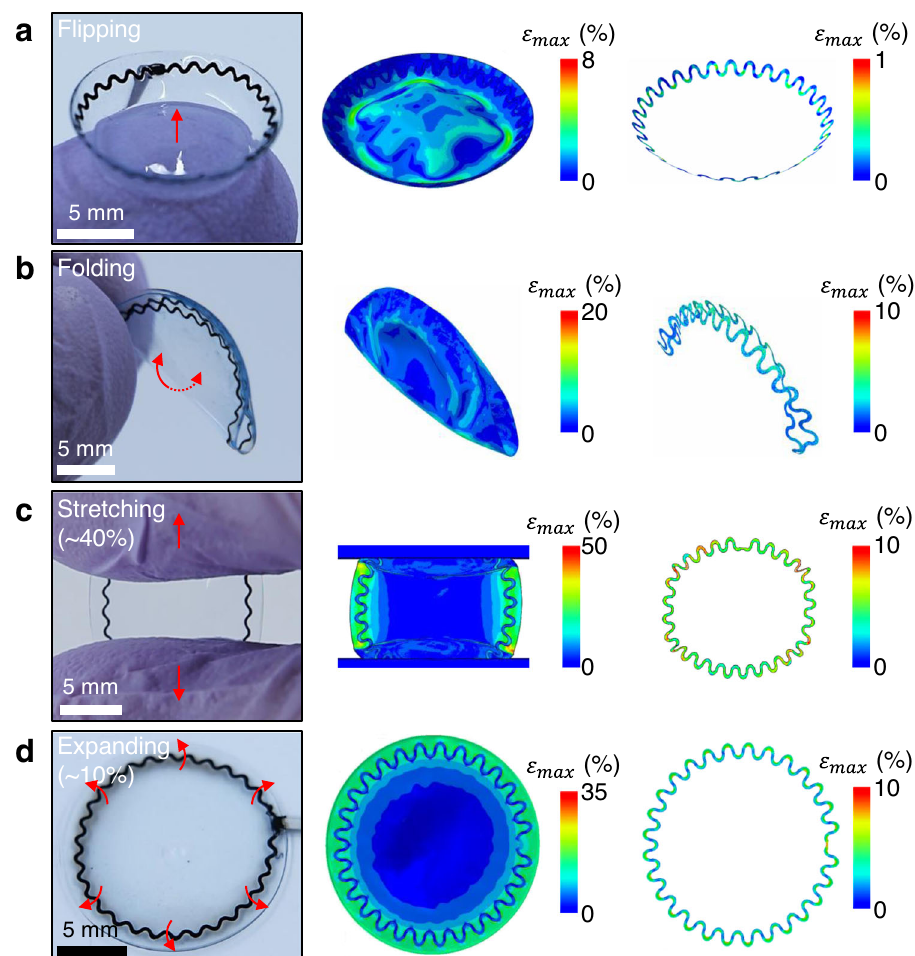
Fig. 3 Mechanics analysis under various loading conditions. Photographs (left column) and fi nite element analysis (FEA) results (middle column) of the corneal sensor under four different loading conditions: a fl ipping, b folding, c stretching (up to 40%), and d expanding (up to 10%). The right column shows the corresponding FEA results of the bare corneal sensor without the